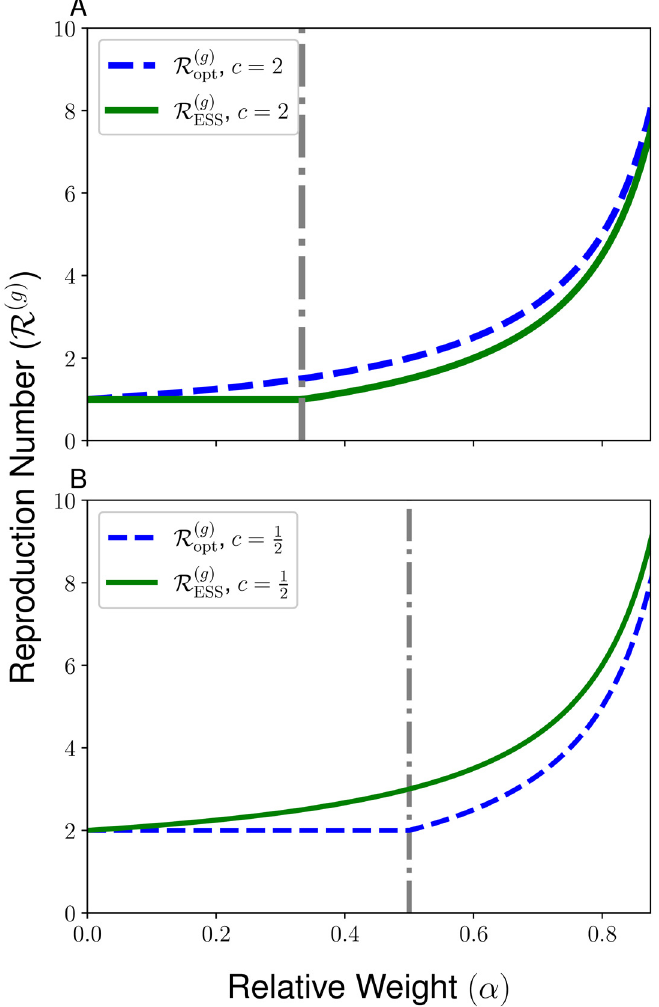
Fig 6. Reproduction numbers R ð g Þ these reproduction numbers as a function of the relative importance of the good contagion α and for the relative infectiousness values c = 2 ( A ) and c ¼ 1